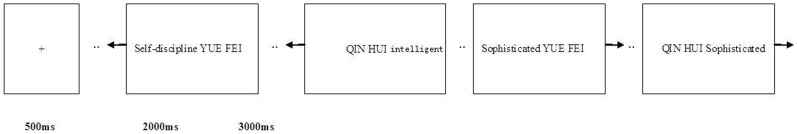
Positive avoidance – negative approach (inconsistent pattern).The Group 2 condition tested an inconsistent pattern based on visual words. A reference name appeared on the center of the screen, and a corresponding personality adjective appeared on either the left or the right side of the reference name.